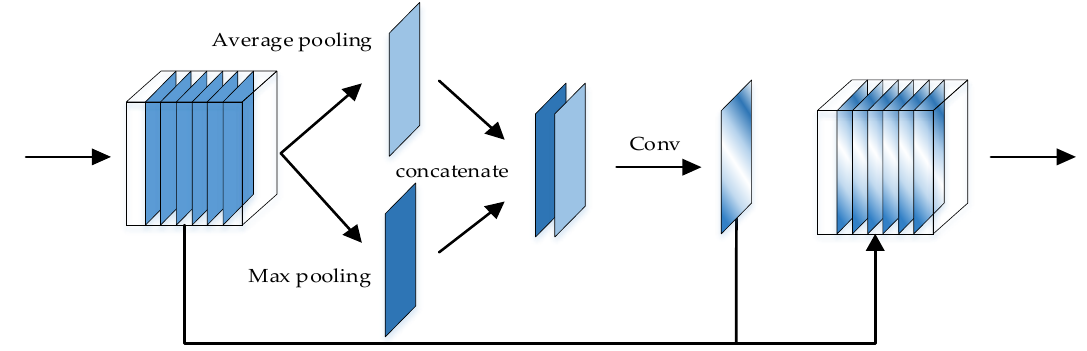
Figure 7. The spatial attention module.